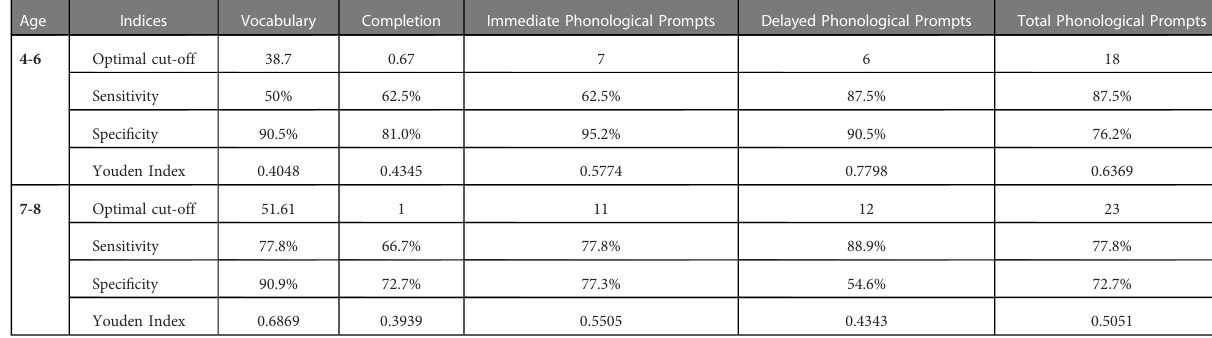
TABLE 10 Diagnostic accuracy for each measure according to age group.